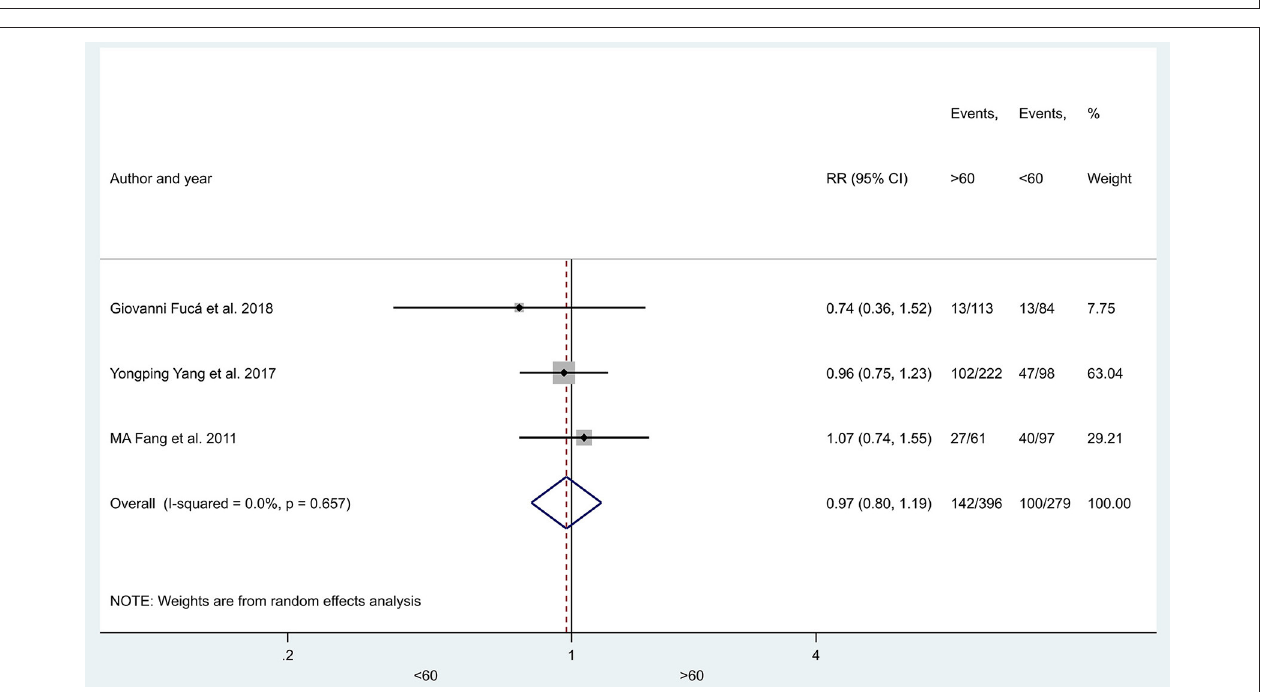
FIGURE 4 | The prevalence of hyponatremia in young ( < 60 years) and older patients ( > 60 years) with lung cancer. Black diamonds represent the individual effects of studies, and vertical lines show the corresponding 95% CI. The size of the gray squares reflects the individual weight of a particular study. The blue diamond shows the overall or summary effect. The outer edges of the diamonds represent the CIs. RR, risk ratio.